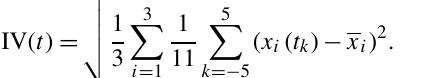
ble mean of the overshoot simulation returns to the reference ensemble is too small (three members) to derive this internal variability from the ensemble spread of single years, we de- fine a measure of internal variability as follows: for a given point in time t we calculate the variance of an annually and spatially averaged time series x i ( t ) for ensemble member i